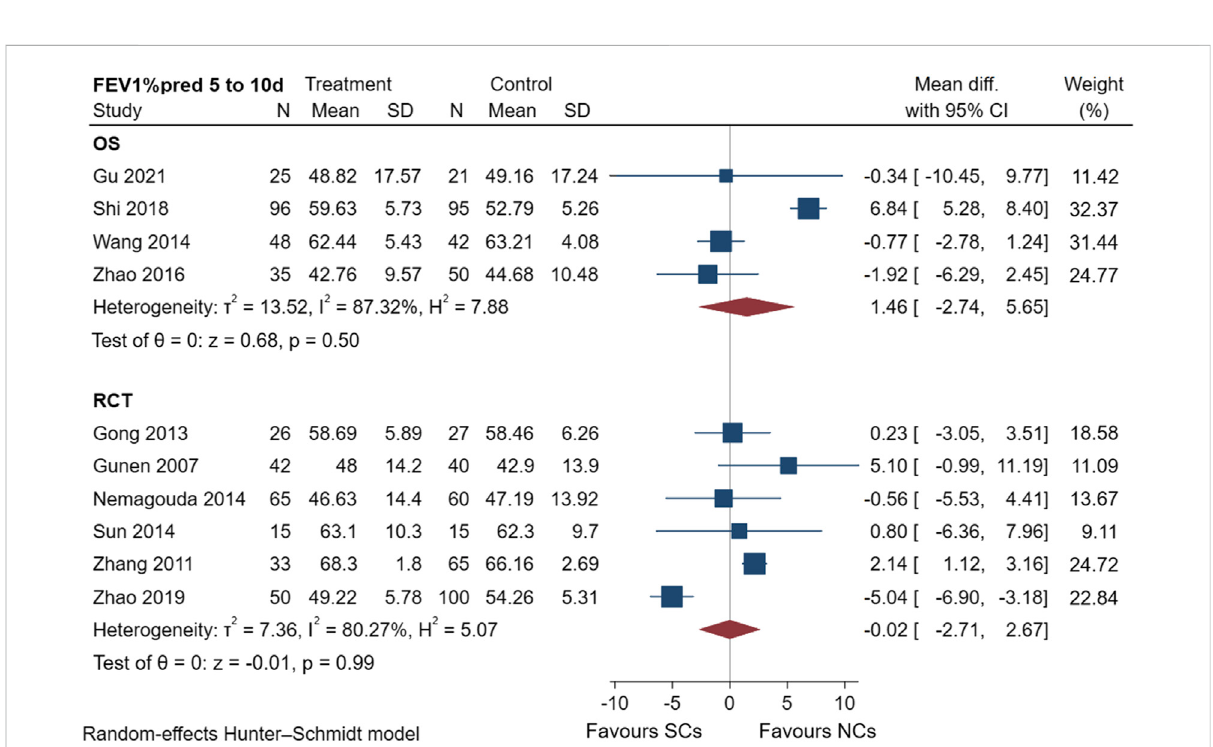
Lung Disease or ATS criteria; reported outcomes including pulmonary function reports, blood gas analysis results, worsening, or adverse events; and literature searches were not limited by the language of the published article or abstract.